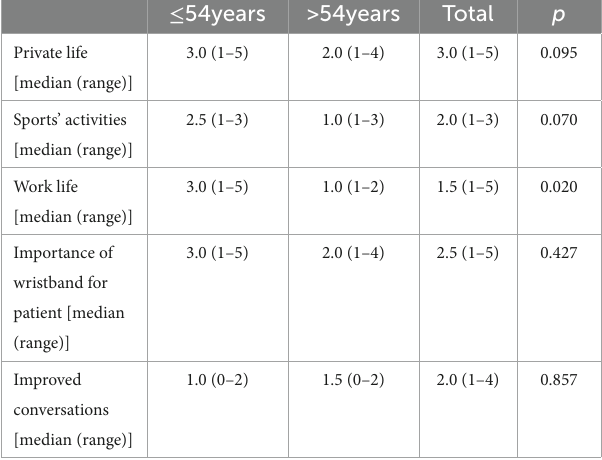
TABLE 4 Age-dependent impacts of colored wristbands on private life, sports’ activities and work life (5 indicating the highest and 1 the lowest score of relevance).